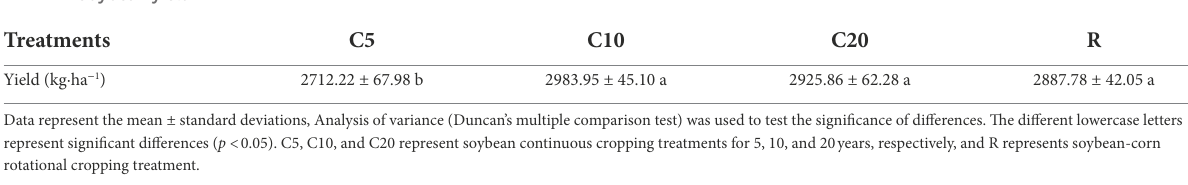
TABLE 1 Soybean yield.